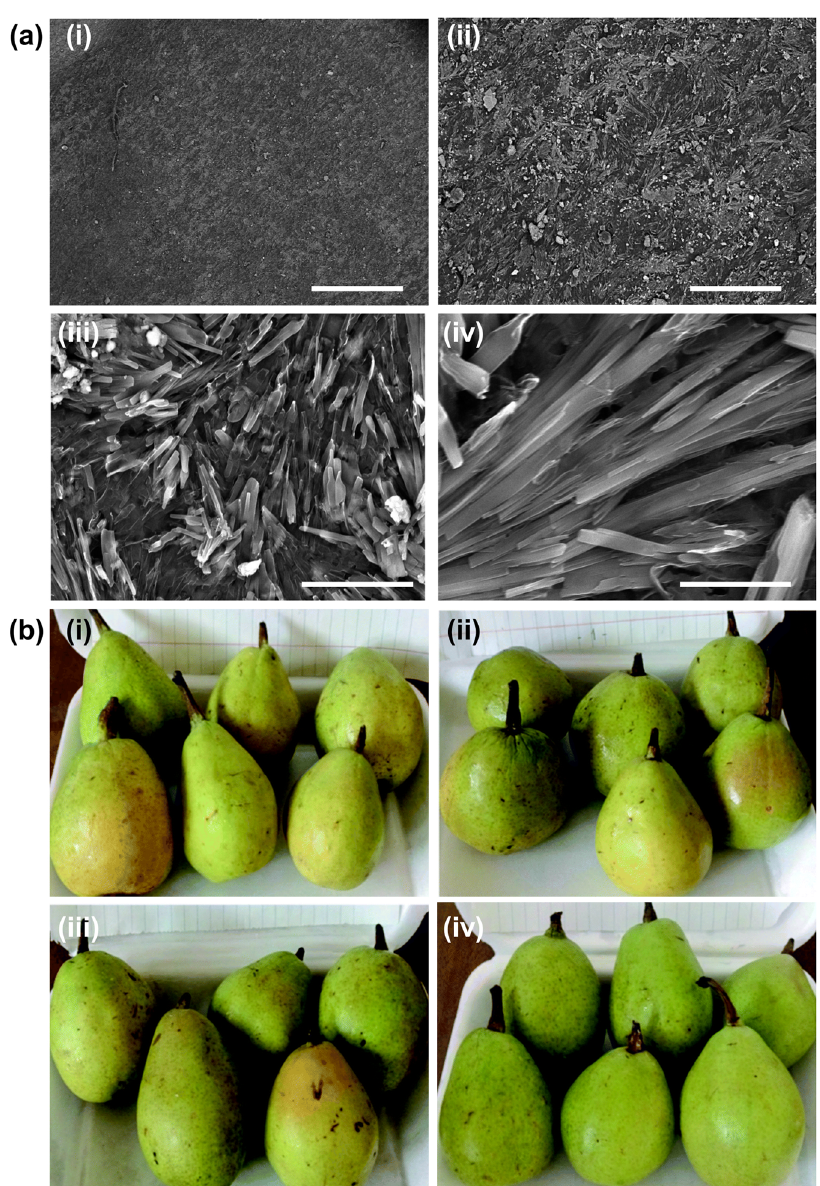
Fig. 5 Surface morphology and performance of the CS-beeswax/pollen grains coating in fruit preservation. a Scanning electron microscopic images of the CS-beeswax/pollen grains coating at various magni fi cation scales. The scale bar in (i), (ii), (iii) and (iv) represents 1 mm, 200 µm, 30 µm and 10 µm, respectively. b Appearance of (i) uncoated pears, (ii) pears coated with CS alone, (iii) pears coated with a mixture of beeswax and pollen grains, and (iv) pears coated with both CS and beeswax-pollen grains. The pears have been stored at 0 ± 1 °C for 105 days and at 23 ± 2 °C for 1 week. Reproduced from 80 with permission from Royal Society of